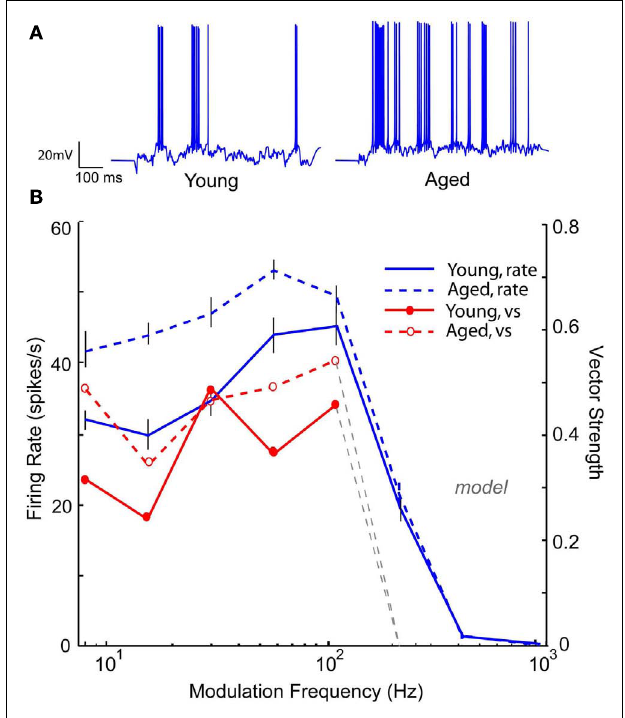
FIGURE 11 |Transformation of band-pass rMTF to low-pass rMTF by reducing GABA A . IC Adapting model with 3 user-defined low-pass excitatory inputs (LSO sync tuning) and 3VNLL band-pass inhibitory inputs (rBMF = 12Hz). (A) Example voltage traces from individual trials at 16Hz modulation frequency for a young (left) and aged (right) model neuron. (B) A band-pass rMTF ( solid blue ) from a model young neuron is transformed into a low-pass rMTF ( dashed, blue ) upon 50% reduction in GABA A .The original vector strength ( solid red ) decreased ( dashed, red ) but the cut-off frequency remained the same. Firing rate, in spikes/s, and vector strength are marked along opposing Y -axes and modulation frequency is marked along the X -axis in